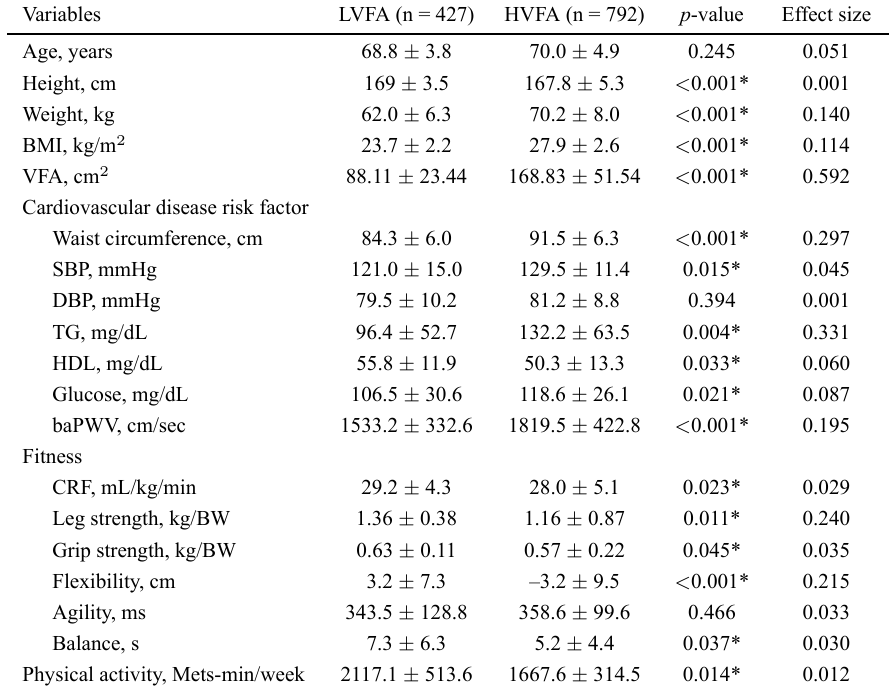
Table 1. General characteristics of the study participants.